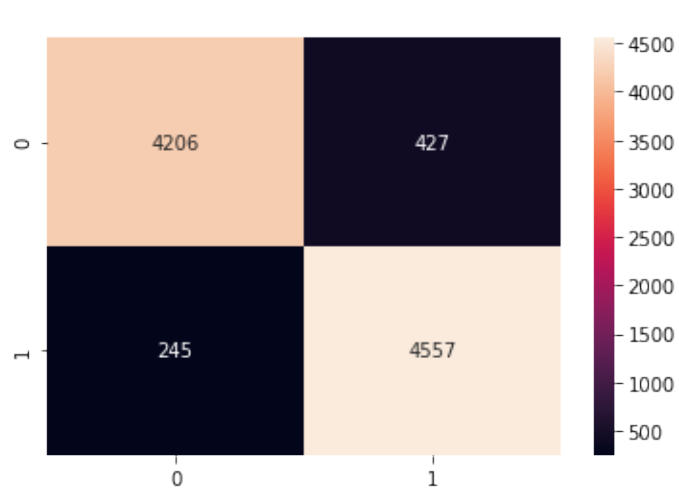
Figure 18. Random Forest metrics.